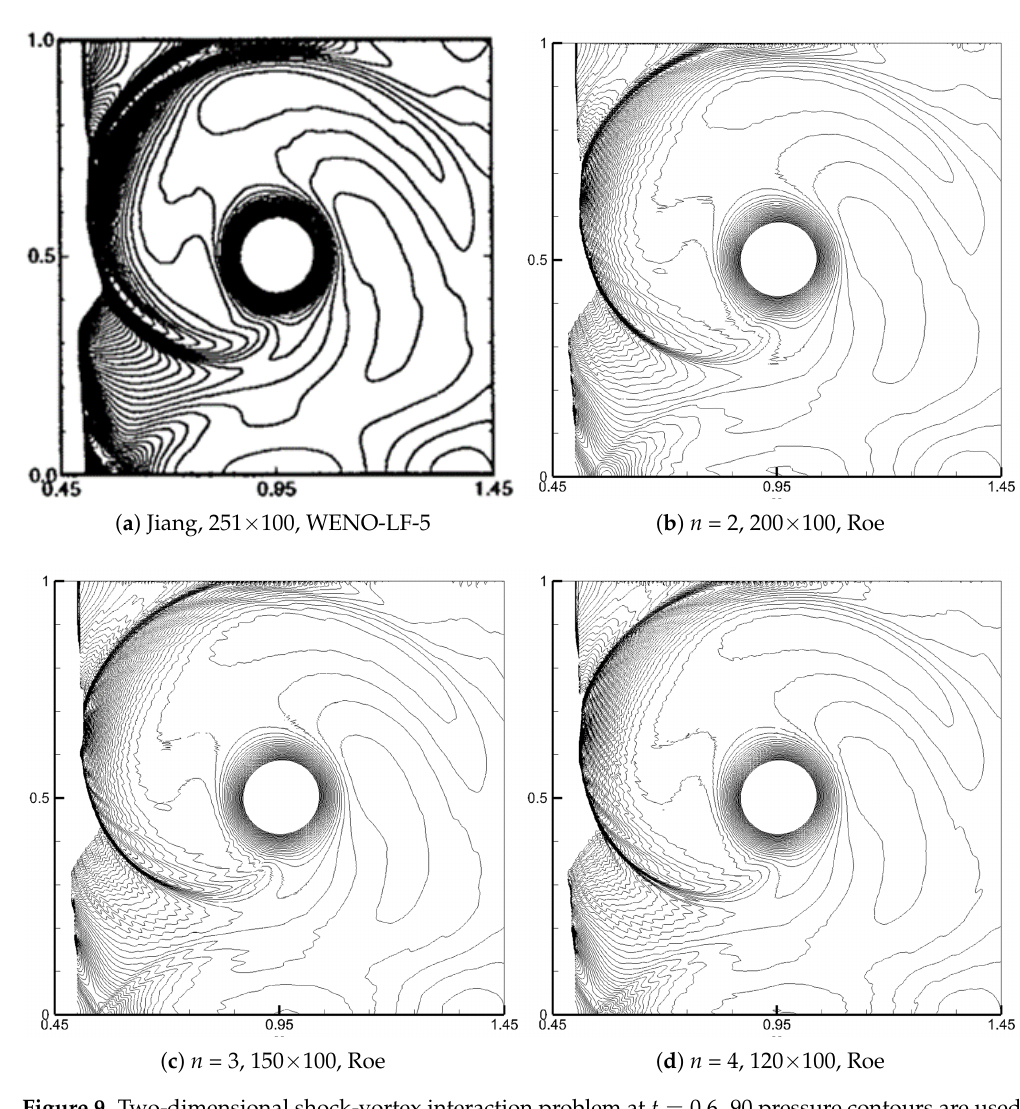
Figure 9. Two-dimensional shock-vortex interaction problem at t = 0.6. 90 pressure contours are used from 1.19 to 1.37. ( a ) WENO-LF-5 results by Jiang et